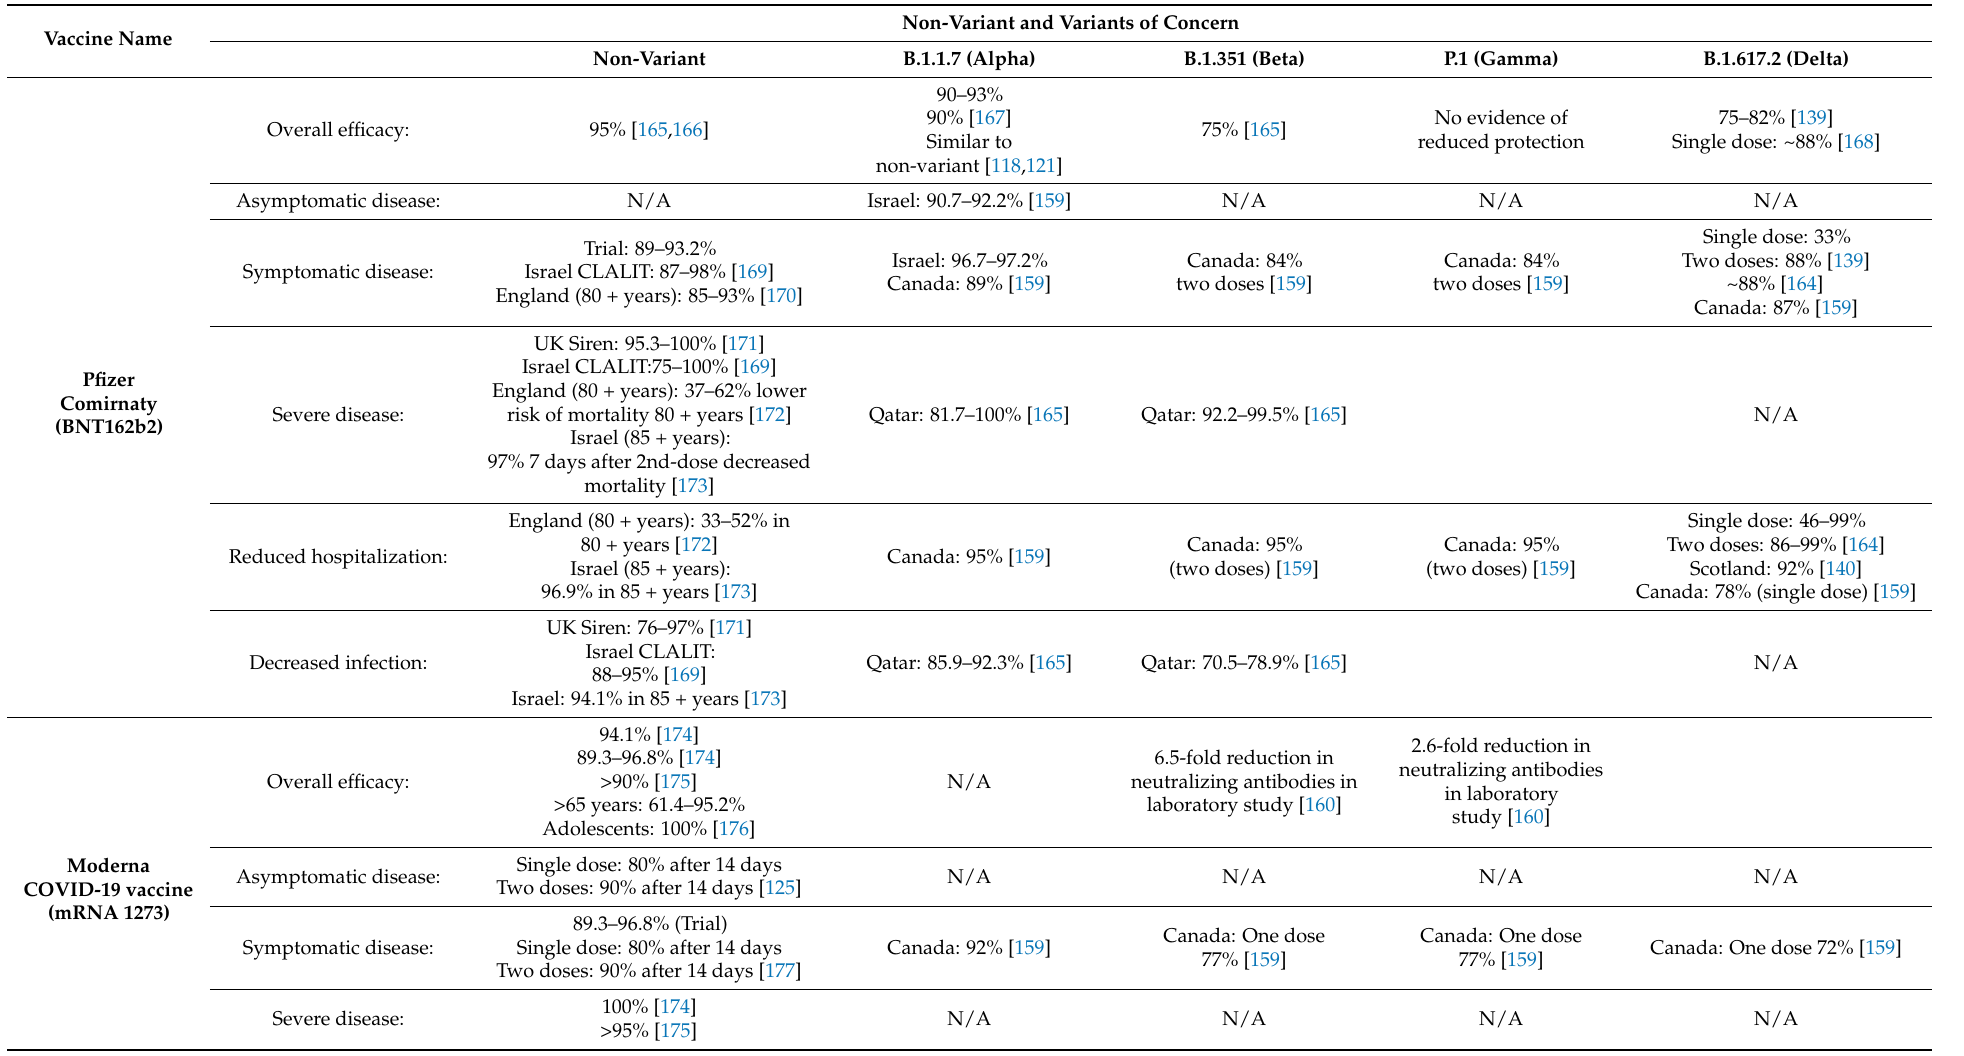
Table 5. Vaccines Efficacy and effectiveness against Variants of